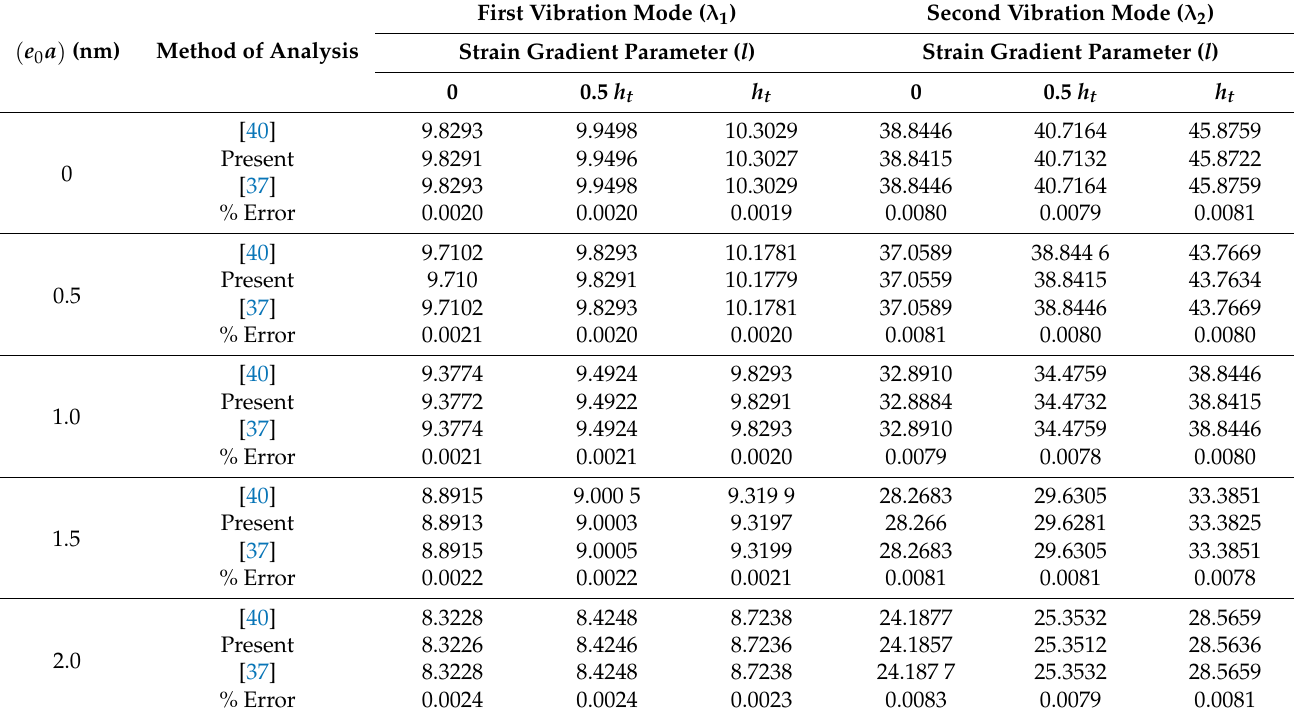
Table 4. Comparison of the estimated nonclassical nondimensional natural frequency parameters (cid:113) 12 ρ λ i = ω ni L 2 for the first and the second vibration modes for an SS homogenous nanobeam E h t without the piezoelectricity effect, where L = 10 nm and h t = 1